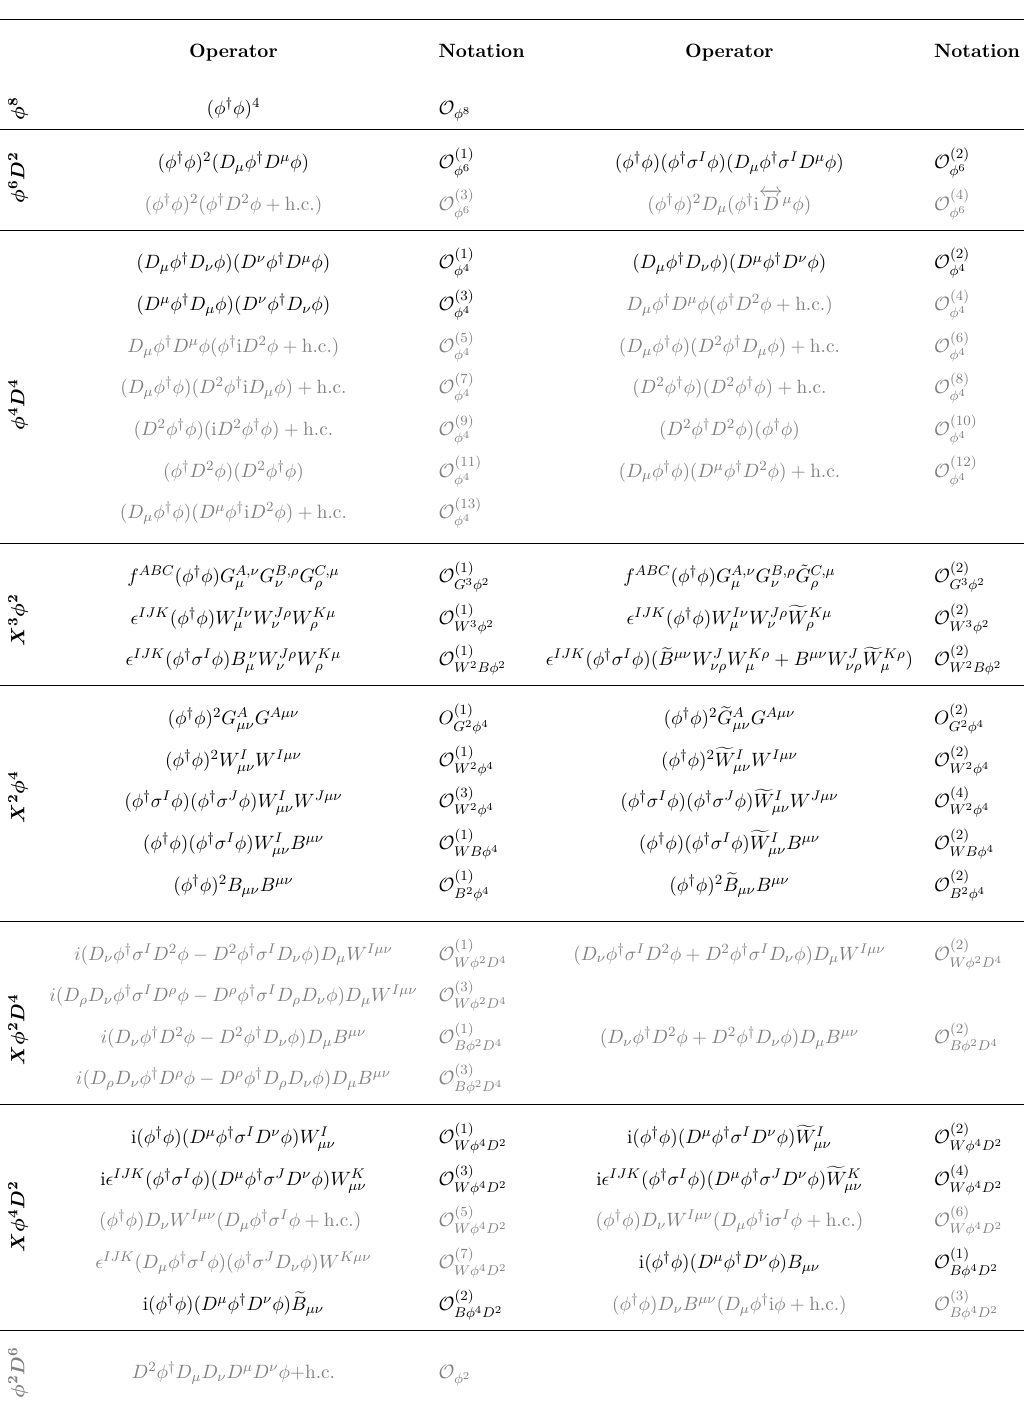
Table 1 . Green’s basis of operators, part I. Operators in gray are